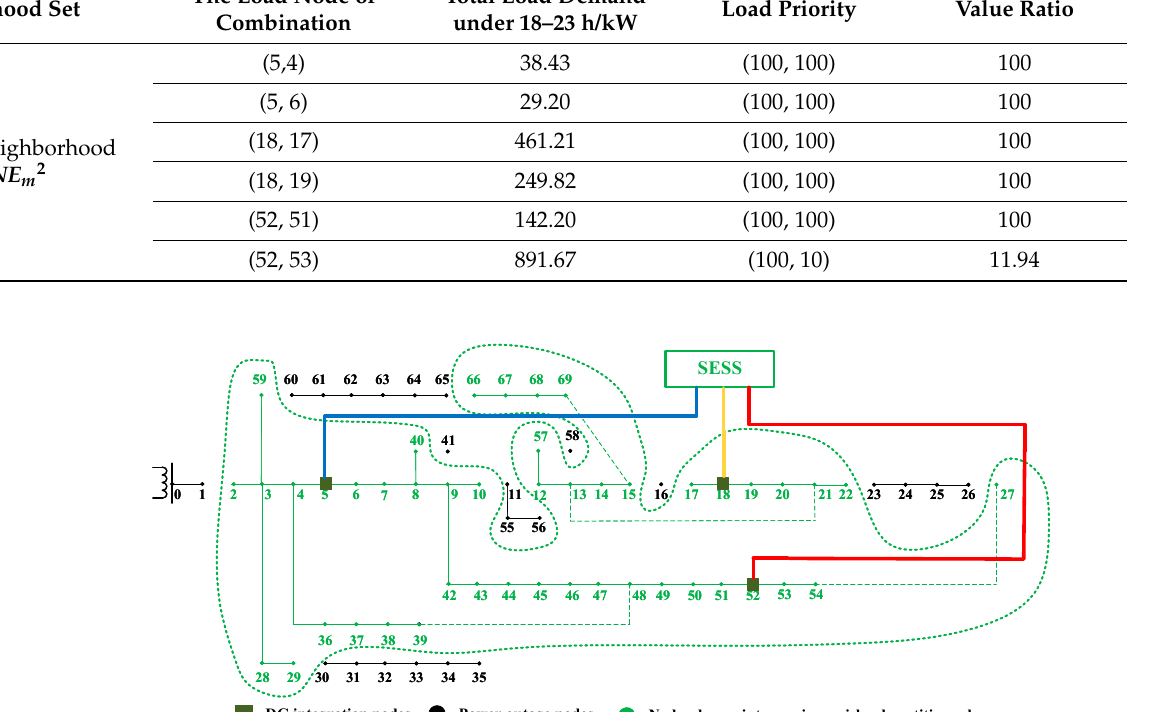
Figure 6. Maximum island partition scheme based on the prospective greedy algorithm.